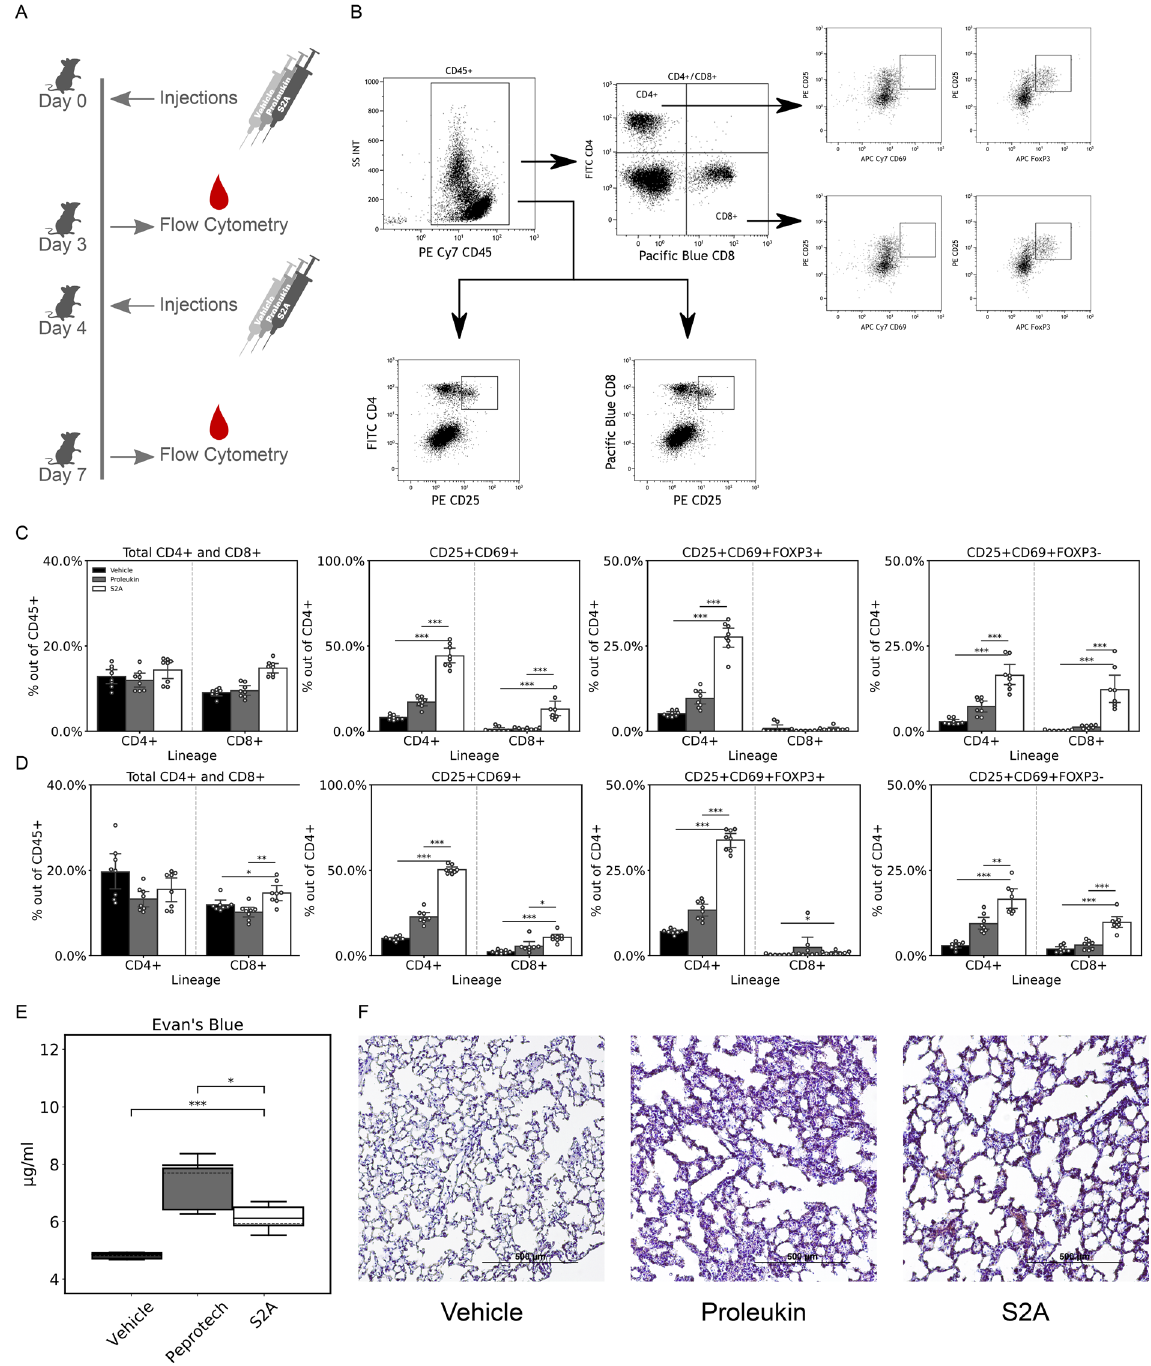
Figure 3. Induction of Treg by S2A inoculation. ( A ) Mice (n = 8 per treatment) were inoculated with 30,000 units of S2A, Proleukin, and the same volume of the vehicle twice. PBMCs were isolated 3 days after each inoculation, stained for C45, CD4, CD8, CD25, FoxP3, and CD69, and then the marker distribution was assessed by FACS. ( B ) Representative FACS gating strategy from a mouse treated with S2A. ( C ) FACS data from a combined dataset of 2 independent experiments collected 3 days after 1st inoculation. Data is arrayed, according to lineage (CD4 + and CD8 +) and presented as a percentage of the indicated population on the y-axis. ( D ) Aggregation of FACS data from day 7 (3 days after 2nd inoculation). Data is arranged as in C. ( E ) Plot-box presenting the results of Evans blue assay from murine lung supernatants (n = 5) under the same conditions (Solid line—mean, crushed line—median). ( F ) Representative stained histological cuts of lungs from mice. Error bars represent 95% CI. *, P < 0.05; **, P < 0.005; ***, P <